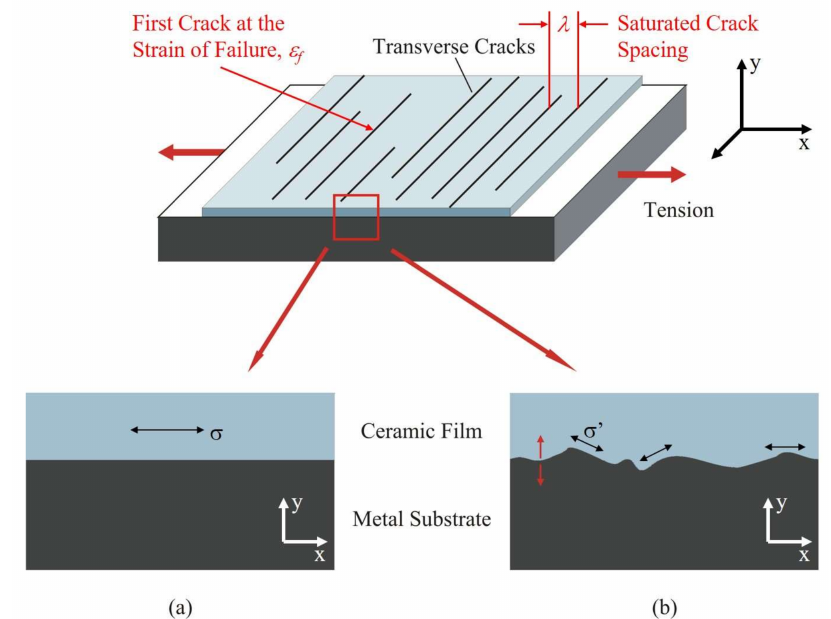
Figure 1. The geometry of the test and the definition of the various quantities with ( a ) referring to the stress state when the interface is flat and ( b ) when the interface is rough. x -axis: direction of applied tension; y -axis: direction perpendicular to the plane of the